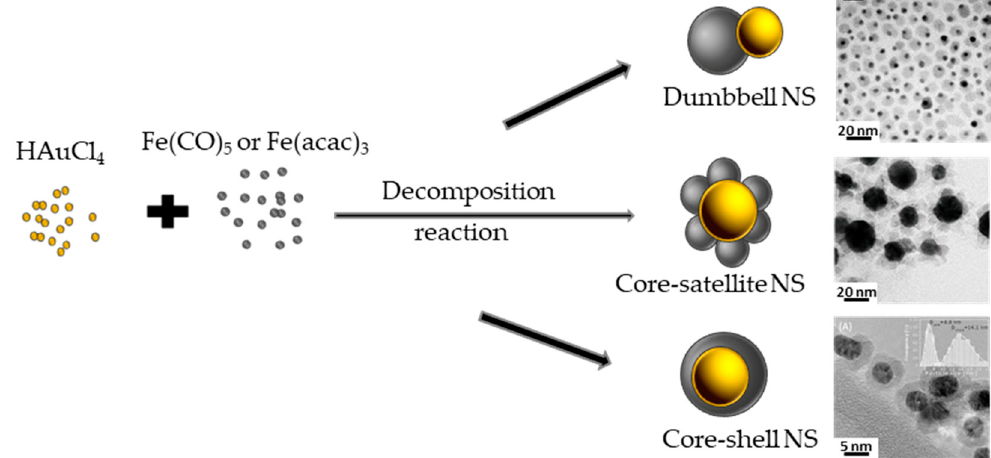
Figure 12. Schematic representation of the one-pot formation of Au-Fe 3 O 4 dumbbell, core-satellite core-shell NSs. Representative TEM image of such NSs, reproduced with permission from [69]. Elsevier, 2012, reproduced with permission from [73]. Elsevier, 2016 and reproduced with permission from [74], are given for illustration.